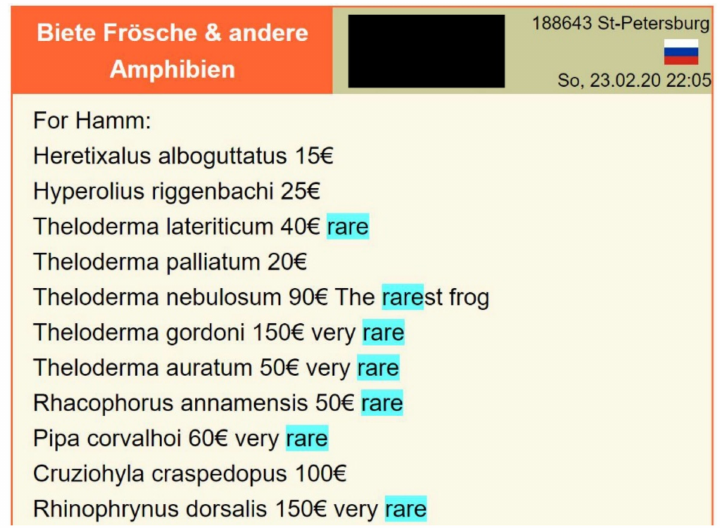
Figure 1. Online advertisement at www.terraristik.com by a Russian trader as of February 2020 (viewed 28 August 2020), advertising di ff erent amphibian species and highlighting the rarity of some. To be sold in “Hamm”, the Terraristika reptile trade show in Germany. Screenshot from terraristik.com of